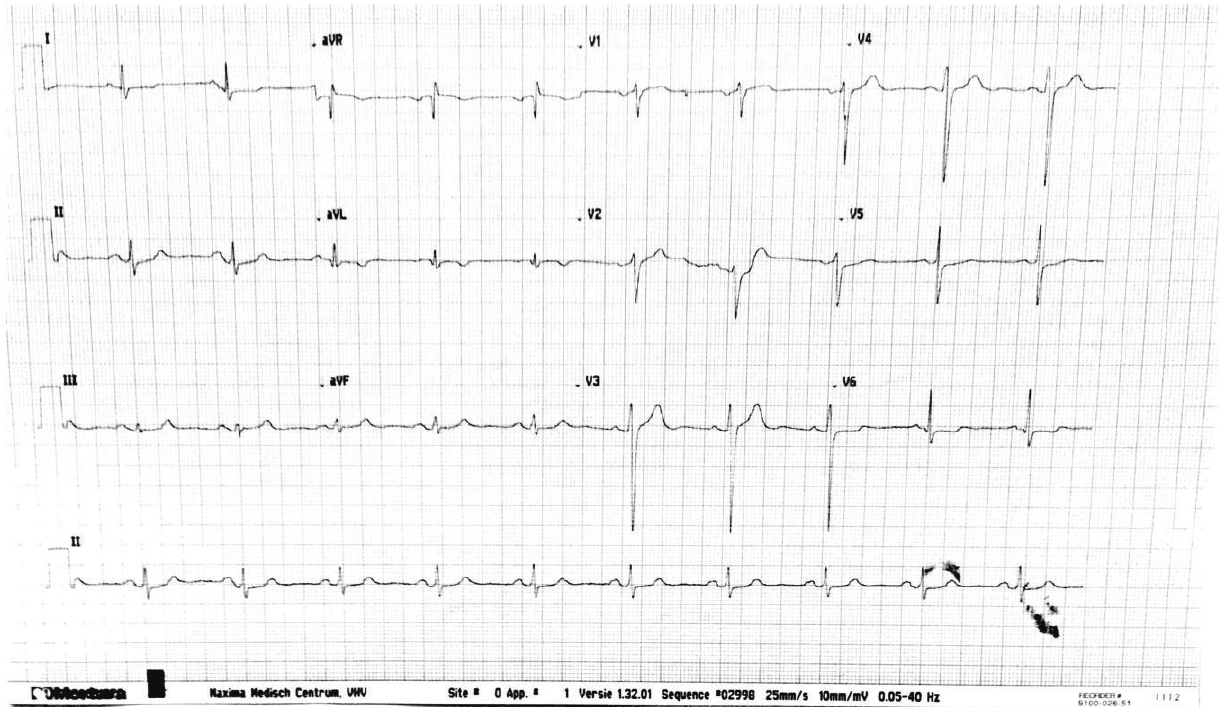
Figure 1: The 12-lead electrocardiogram of the patient presented in the case. The ECG revealed sinus rhythm with normal conduction and with modest repolarization abnormalities in leads aVL and V6.